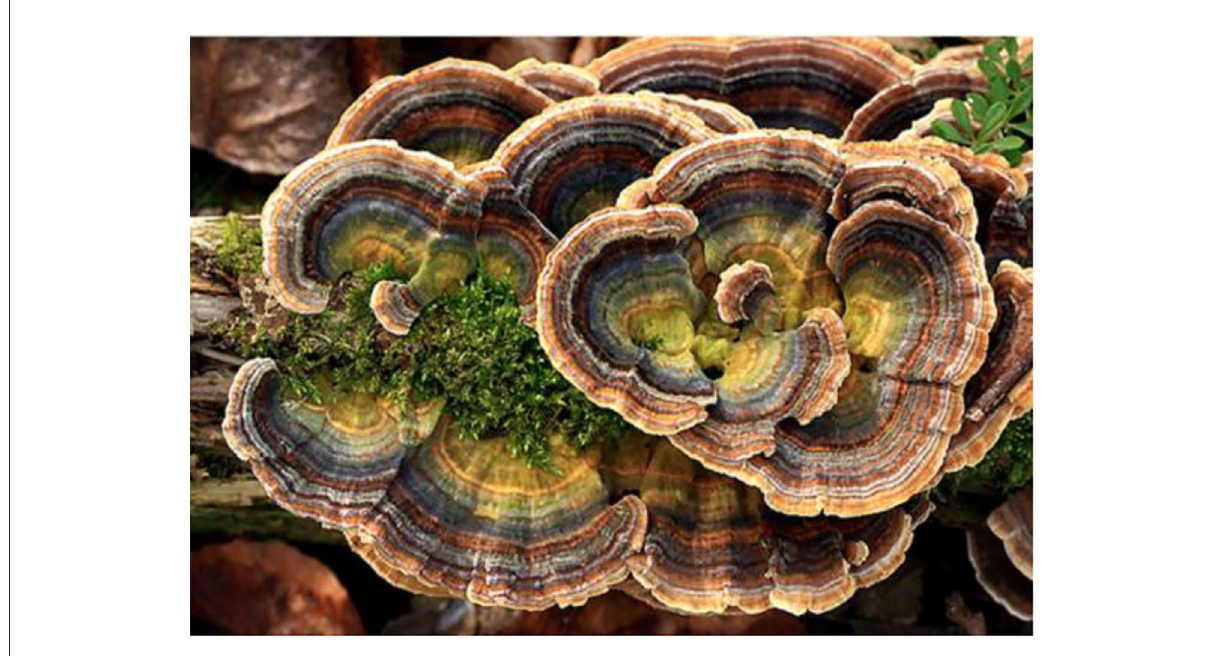
FIGURE11 Edible, not eatable, Coriolus versicolor